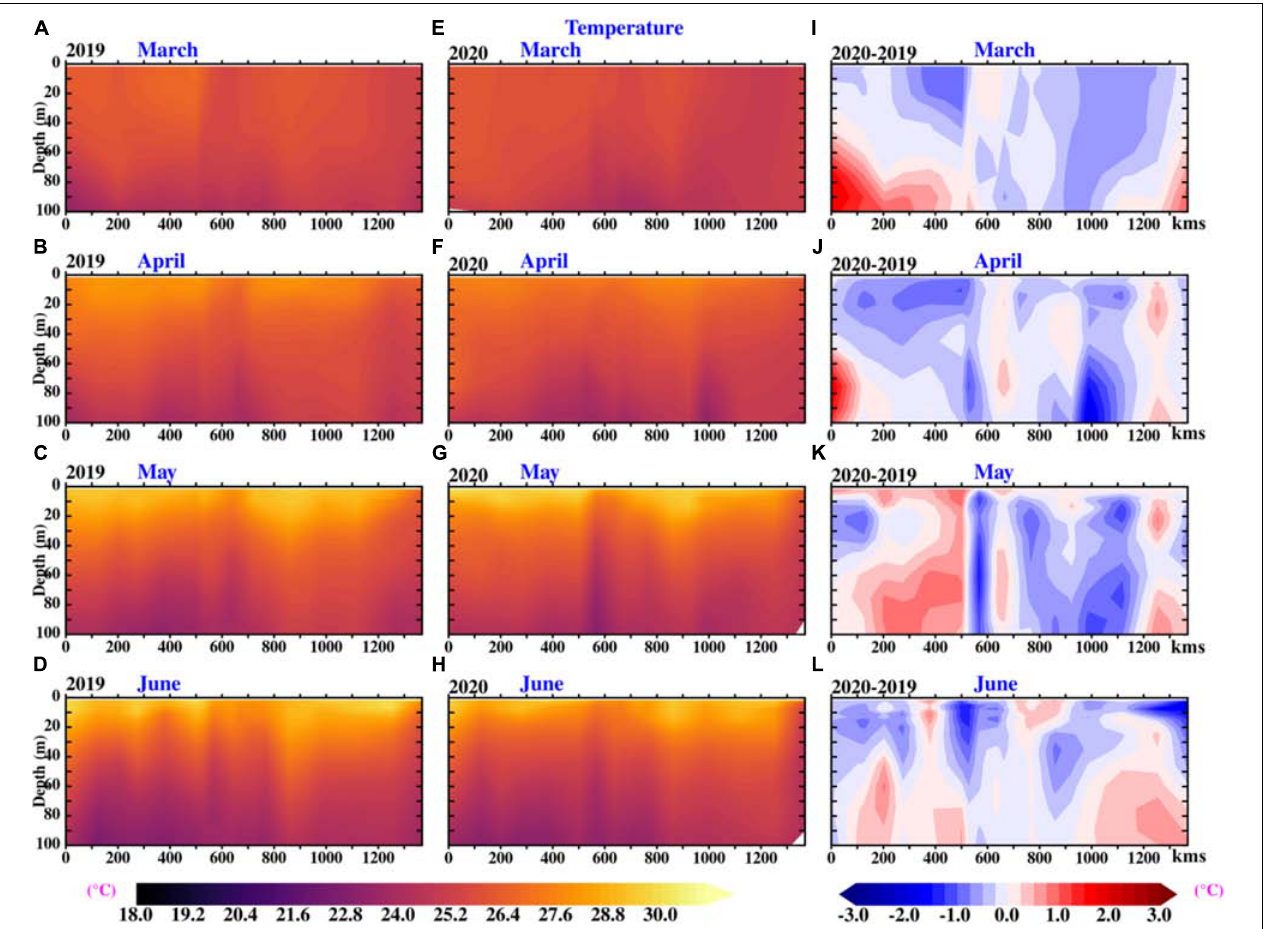
FIGURE 13 | Evolution of model-simulated temperature profile along 1,000 m isobath off Oman coast (as shown in Figure 1 ): (A–D) during the pre-pandemic period (March–June, 2019), (E–H) pandemic period (March–June, 2020), and (I–L) temperature difference (pandemic–pre-pandemic